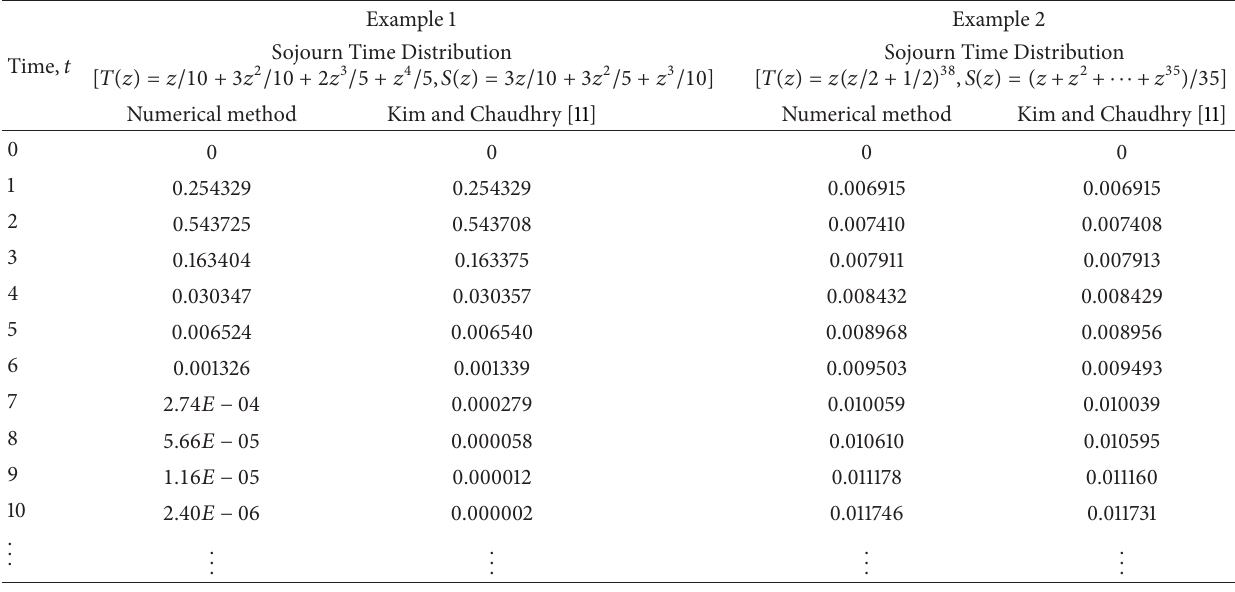
Table 8: Comparison of stationary sojourn time distributions computed by using the proposed numerical method and that given in Kim and Chaudhry [11] ( Δ𝑡 = 1.0).